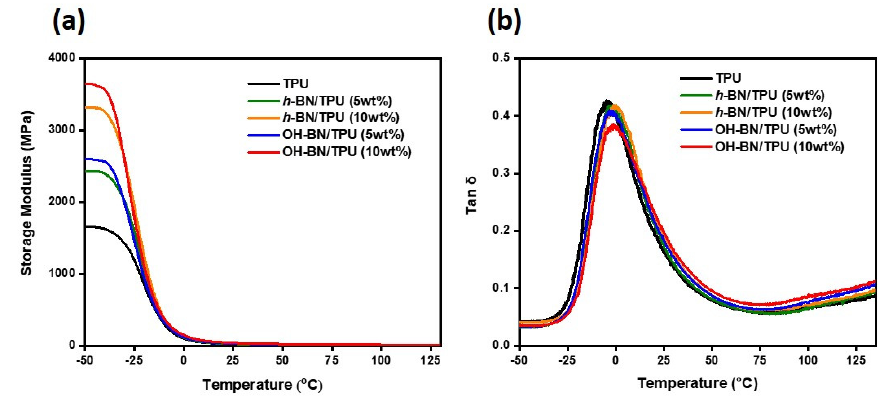
Figure 7. ( a ) Storage modulus and ( b ) loss factors (tan δ ) versus temperature of pure TPU compared with the h -BN/TPU and OH-BN/TPU composites (at 5 and 10 wt.% filler concentrations).